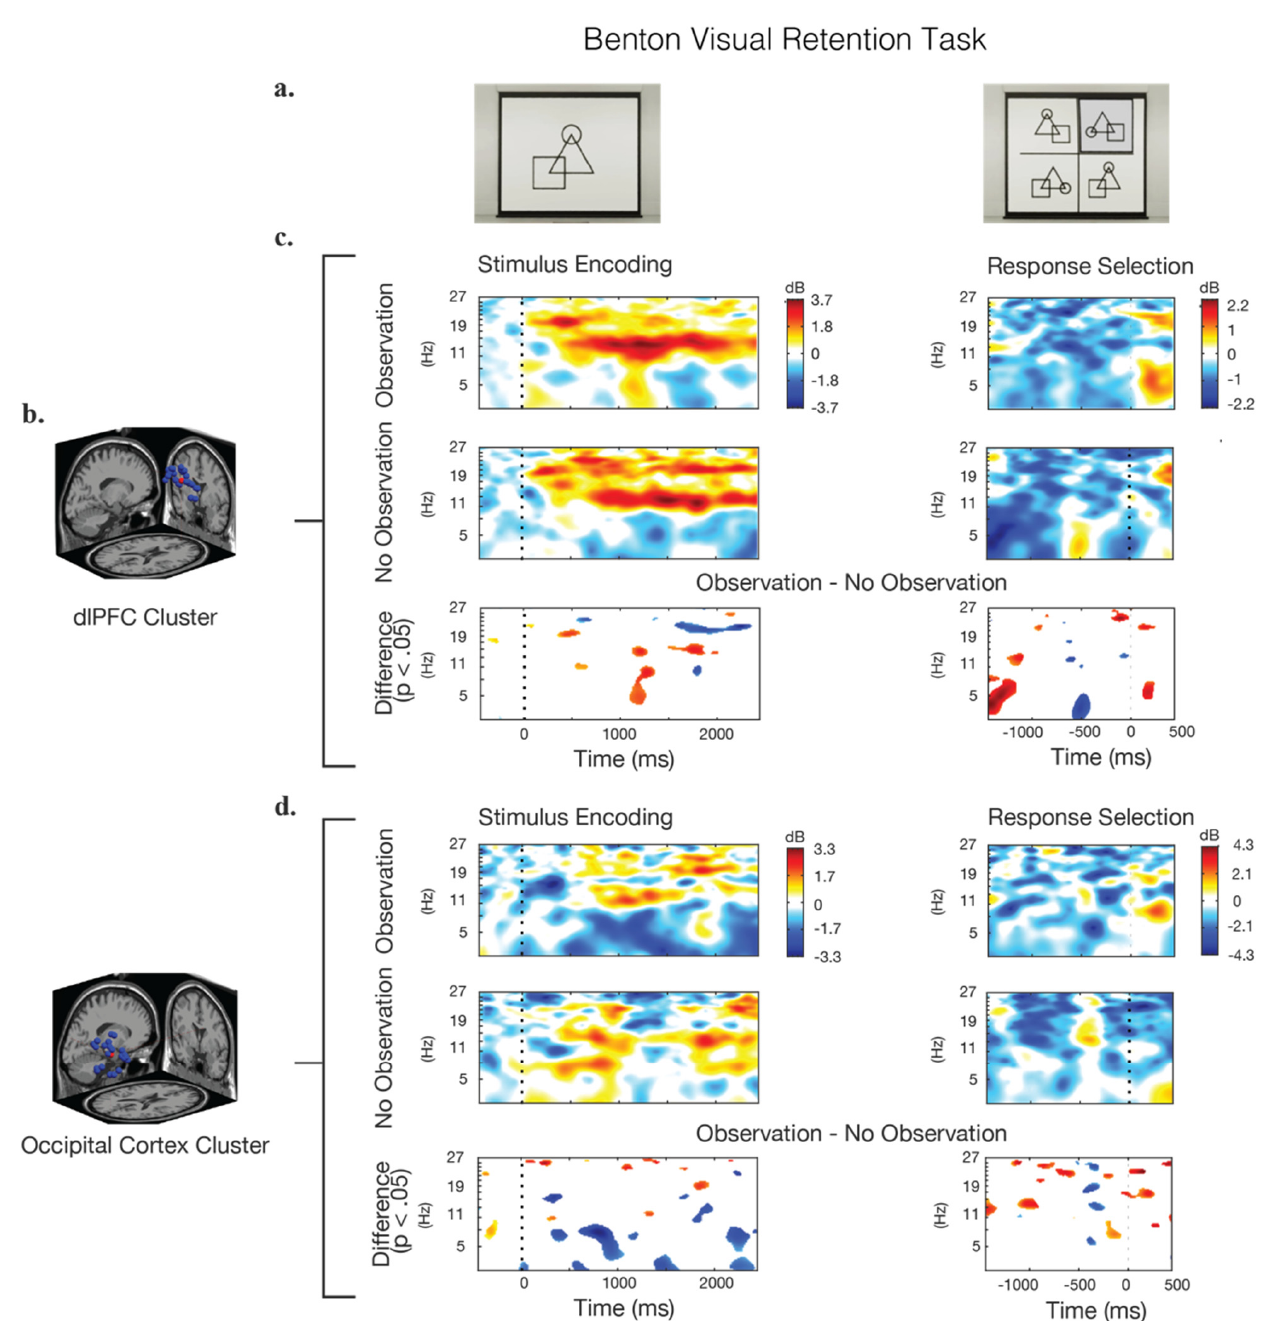
Figure 4. Event-related spectral perturbations (ERSP) during the stimulus presentation and response epochs for the Benton test. ( a ) Screenshot examples of the visual stimulus and response options. ( b ) The IC clusters selected for analysis were located in the dorsolateral prefrontal cortex (dlPFC) and the occipital cortex (OC); the locations of the individual IC dipoles are shown in blue, and the equivalent dipole location is shown in red. ( c , d ) Calculated ERSPs for the observation condition, the no-observation condition, and their significant differences. Frequency power is baselined to the beginning of the trail. Blue regions in the difference graphs indicate that the observation condition showed significantly lower power, while red regions indicate that the observation condition showed significantly higher